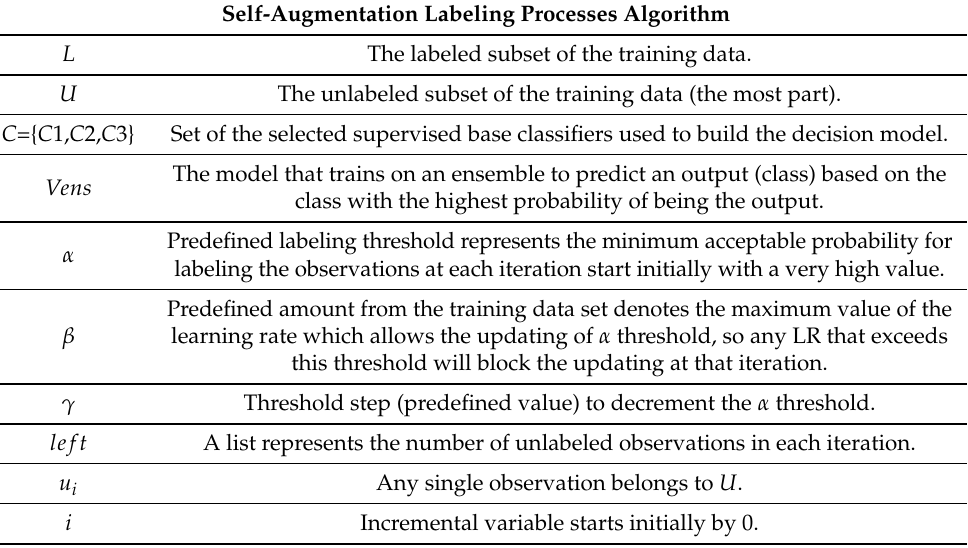
Table 2. Variables, data structures, and functions employed by Algorithm